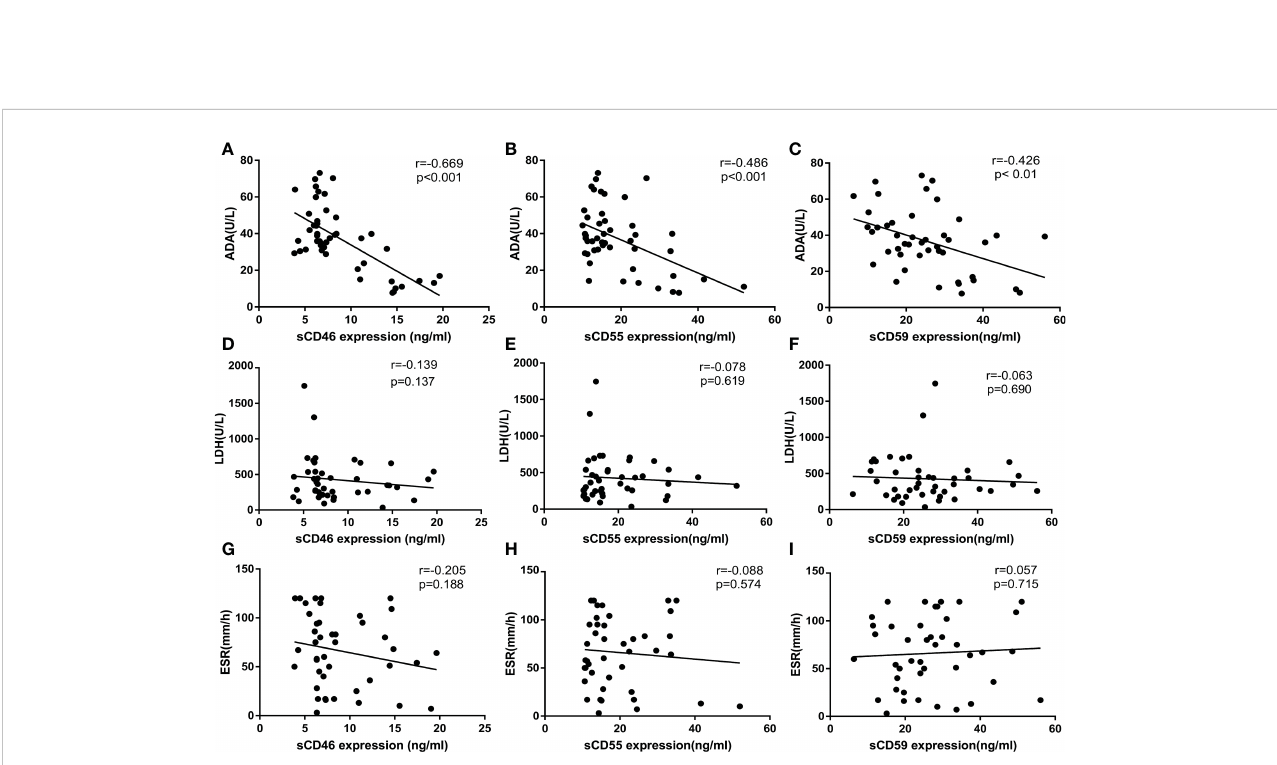
FIGURE 4 Correlation analysis of sCD55, sCD46, sCD59, ADA, LDH, ESR. (A – C) Correlation analysis of sCD46, sCD55 and sCD59 with ADA(N=99). (D – F) Correlation analysis of sCD46, sCD55 and sCD59 with LDH(N=99). (G – I) Correlation analysis of sCD46, sCD55 and sCD59 with ESR(N=99). Correlations were determined by Pearson correlation coef fi cients. sCD46 sCD55 and sCD59 content in PE were negatively correlated with ADA (r = -0.668, P< 0.001 , r = -0.486, P< 0.001 and r = -0.426, P < 0. 01 respectively), which indicated that sCD46 sCD55 and sCD59 could turn into an effective biomarker for PE differential